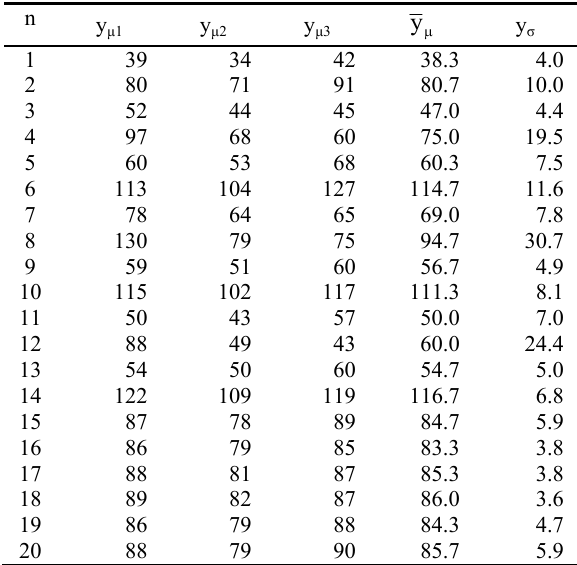
Table 1. Experimental results for the Roman-style catapult